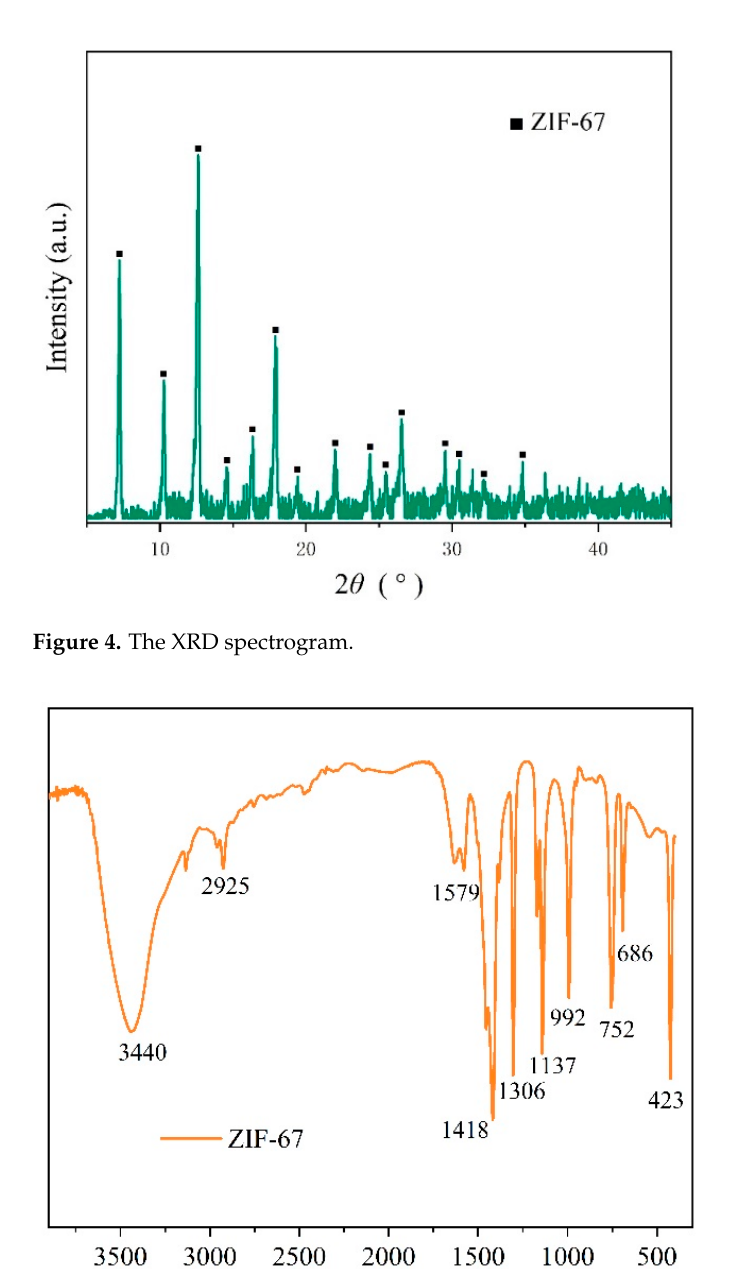
Figure 3. The 1 HNMR spectrogram (in DCl).